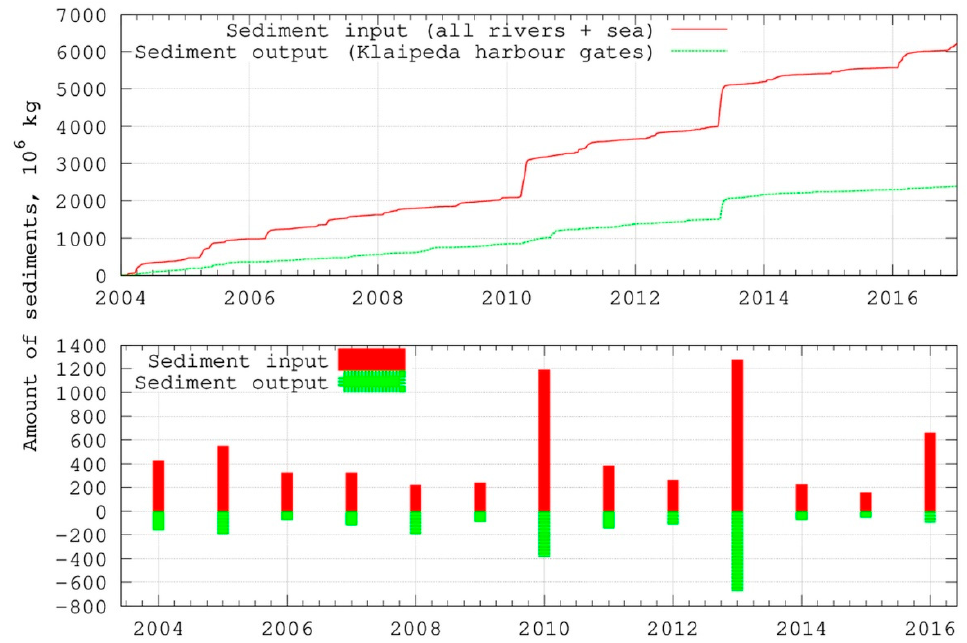
Figure 9. The cumulative amount of sediments coming into the system.